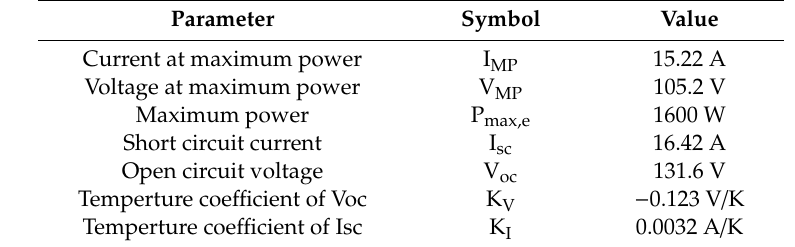
Table 2. Parameters of each PV string in the nominal solar irradiance (1000 W / m 2 ) [46].